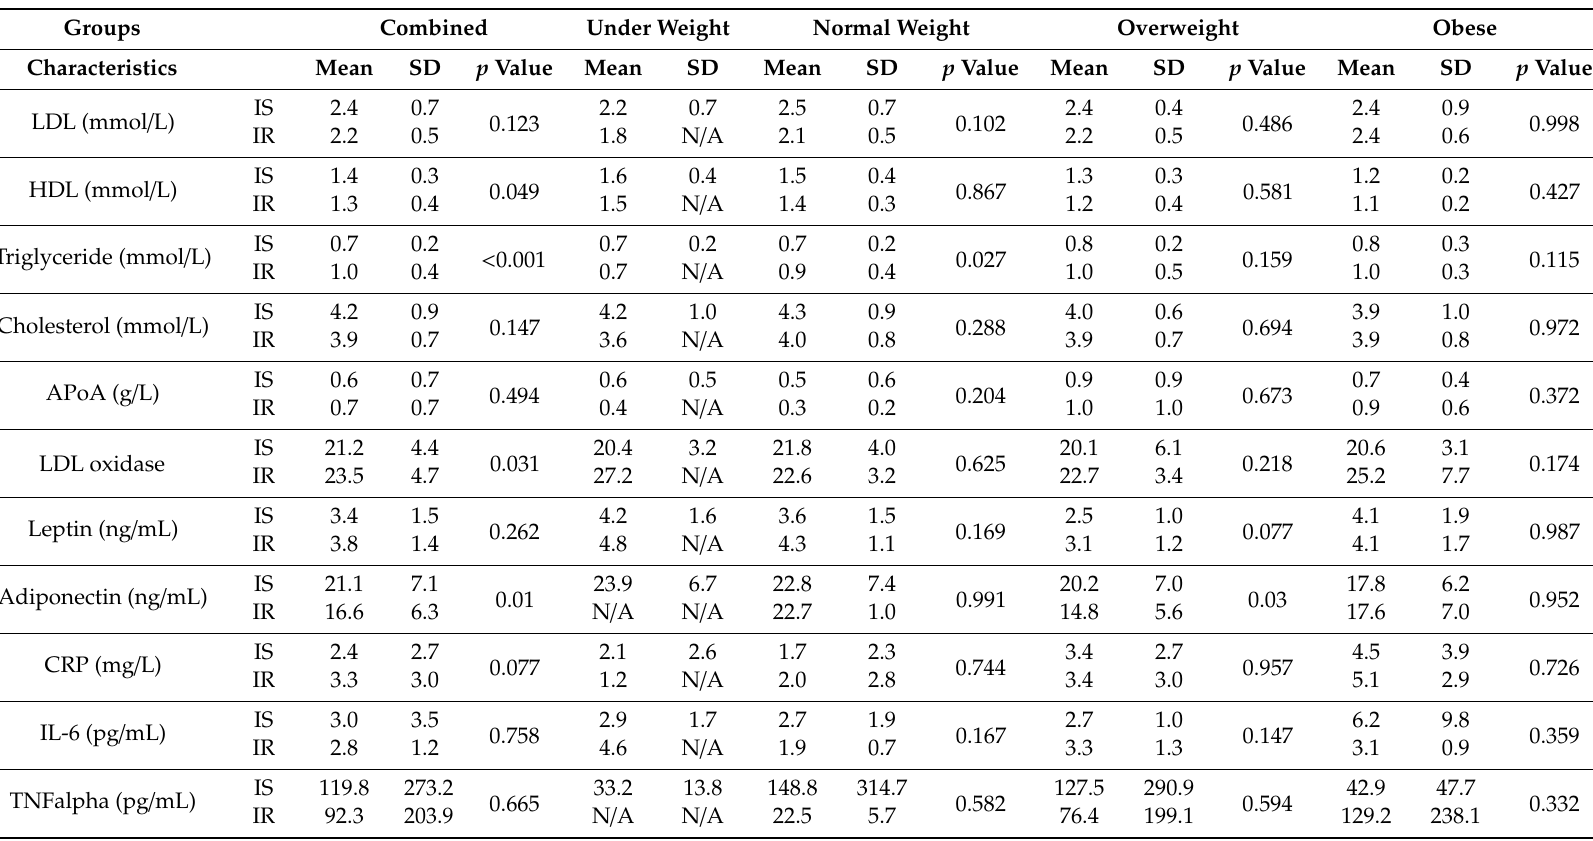
Table 2. Profiles of lipids and adipokines in underweight, normal weight, overweight and obese insulin sensitive (IS) and insulin resistant (IR) participants. Groups Combined Under Weight Normal Weight Overweight Obese Characteristics Mean SD p Value Mean SD Mean SD p Value Mean SD p Value Mean SD p Value IS LDL (mmol / L) IS HDL (mmol / L) IS 0.7 0.2 Triglyceride (mmol / L) IS 4.2 Cholesterol (mmol / L) 0.147 IS APoA (g / L) LDL oxidase